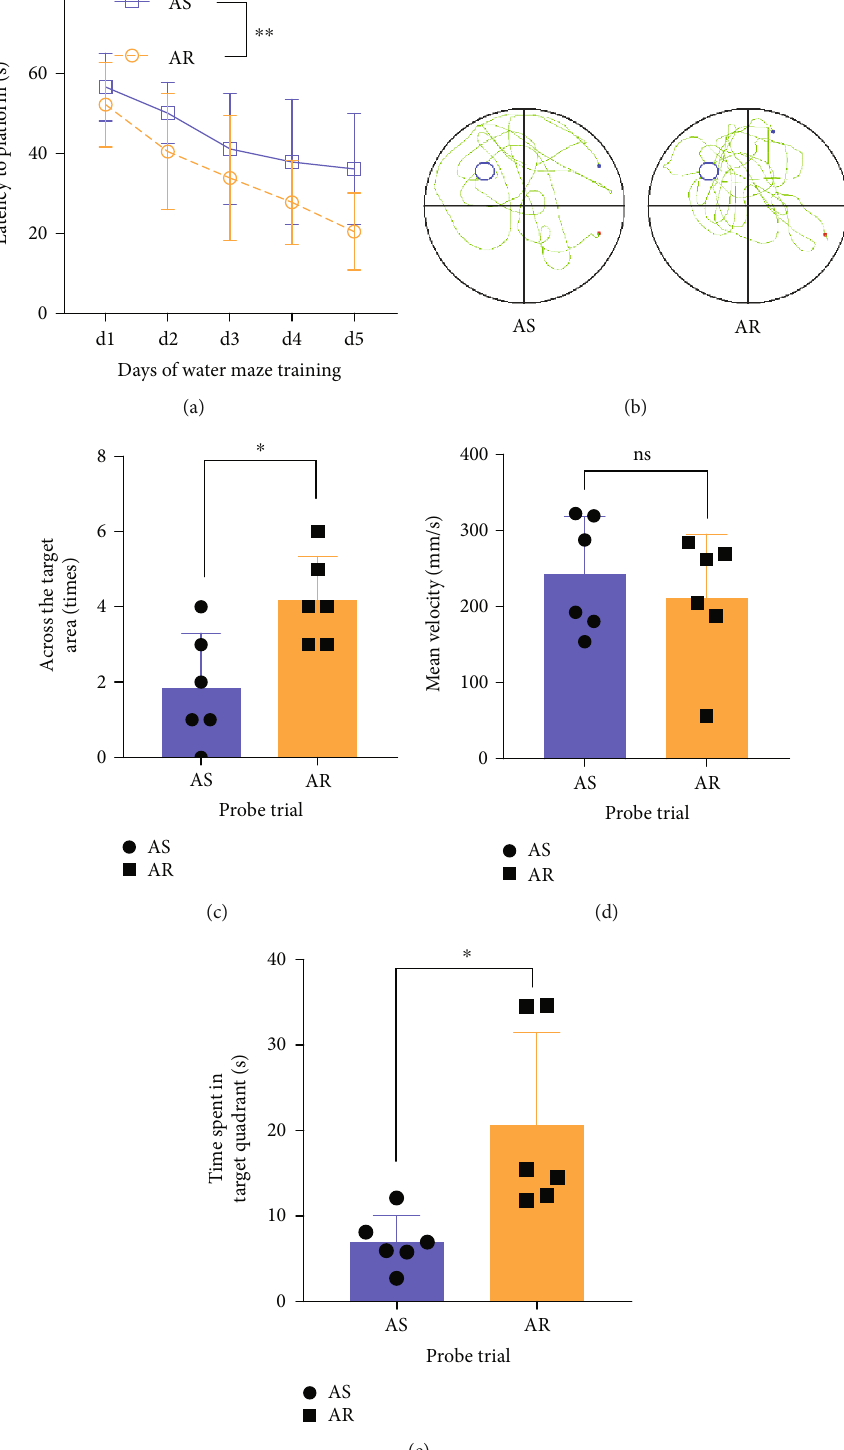
Figure 2: Morris water maze test of spatial cognitive function. (a) Statistical analysis of the latency to reach the platform during the MWM training in the AS and AR groups. (b) Representative swim paths of the mice in the AS and AR groups. (c) Statistical analysis of the number of times crossing the target platform in the AS and AR groups. (d) Statistical analysis of the mean velocity during exploration in the AS and AR groups. (e) Statistical analysis of the percentage of time spent in the target quadrant by the AS and AR groups. Data are presented as the mean ± SD ( n = 6 mice per group, two-way ANOVA with Tukey ’ s test for multiple comparisons, unpaired t -test for comparing two individual groups; ∗ P < 0 : 05 , ∗∗ P < 0 : 01 , ∗∗∗ P < 0 : 001 , and ∗∗∗∗ P < 0 : 0001